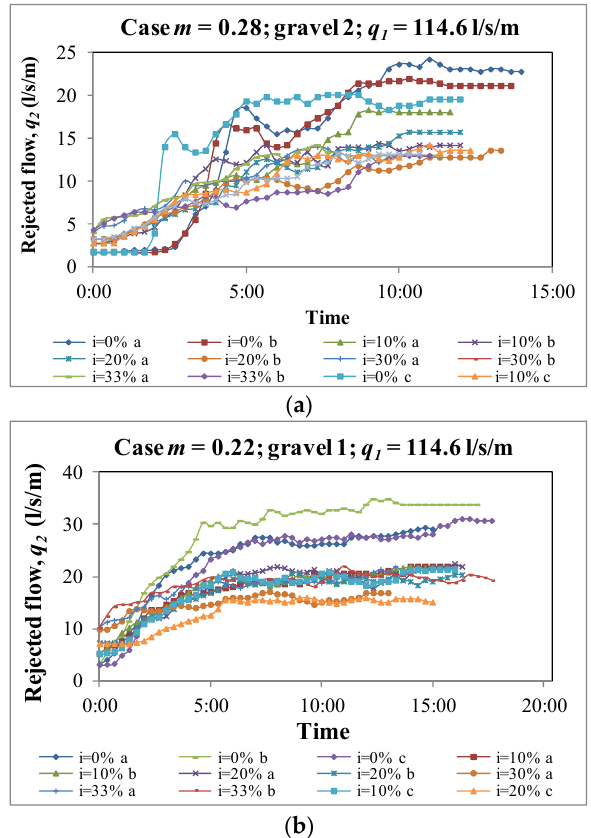
Figure 8. Time evolution of the rejected flow for different longitudinal rack slopes and test with q 1 = 114.6 l/s/m and two different void fractions ( m = 0.22 ( a ) and 0.28 ( b )). In general, a lower rack slope with gravel transport drives to higher rejected flow, q 2 . This is opposed to the clear water case, where the smaller slopes result in lower values of rejected flow. It should be highlighted that differences are observed between the rejected flow in horizontal racks and the other slopes, due to the large obstructions reached with the horizontal slope.